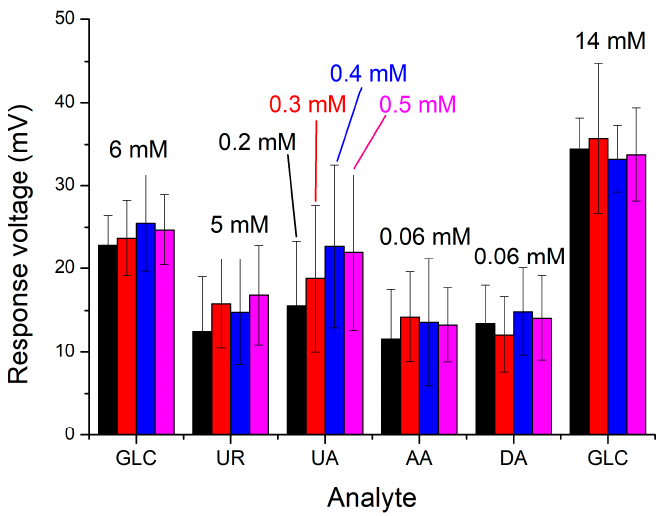
Figure 16. Interference effects of the AgNWs/CZO glucose sensor under different interferences.